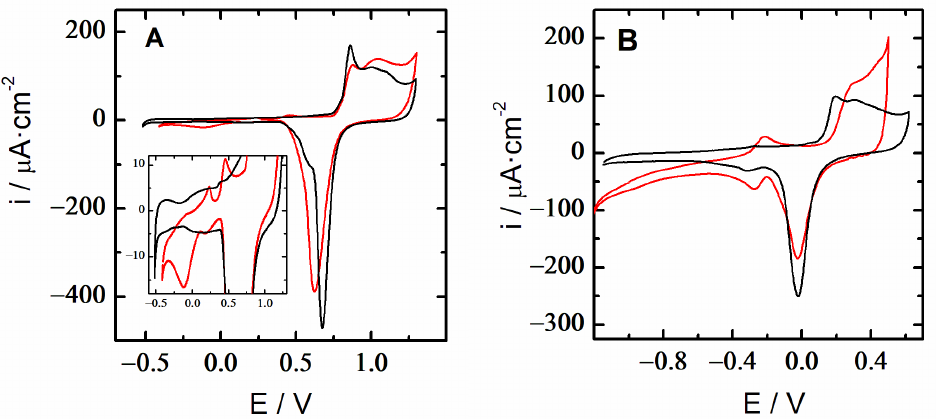
Figure 5. Cyclic voltammetry of 18K quaternary gold alloy (red) and pure polycrystalline gold (black) in ( A ) 10 mM HClO 4 and ( B ) 0.1 M NaOH. Scan rate 100 mV/s.